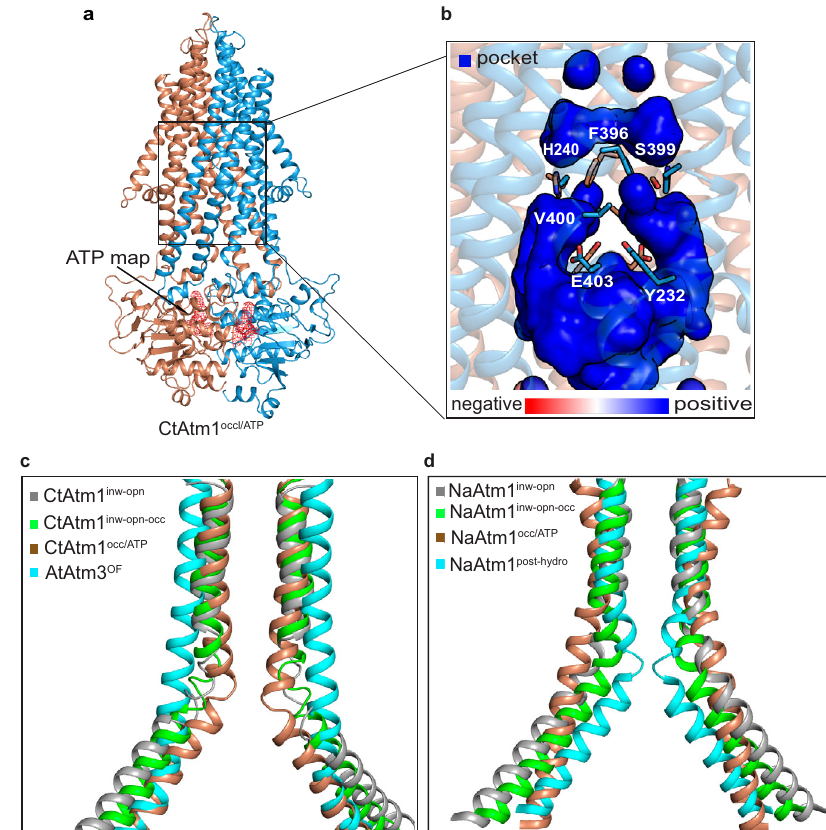
Fig. 4 |Theoccludedstructurewith bound ATP.a The occluded structure with bound ATP, CtAtm1 occl/ATP , with the supporting cryo-EM density for ATP (red) and the protein colored as in Fig. 1d. b Close-view of the occluded highly electropositive pocket. Residues Y232, E403, and V400 divide the pocket next to the inner gate. The interactions between H240, F396, and S399 separate the pocket from the pathway on the other side of F396. c Comparison of the conformation of transmembrane helix TM6 between the inward-open